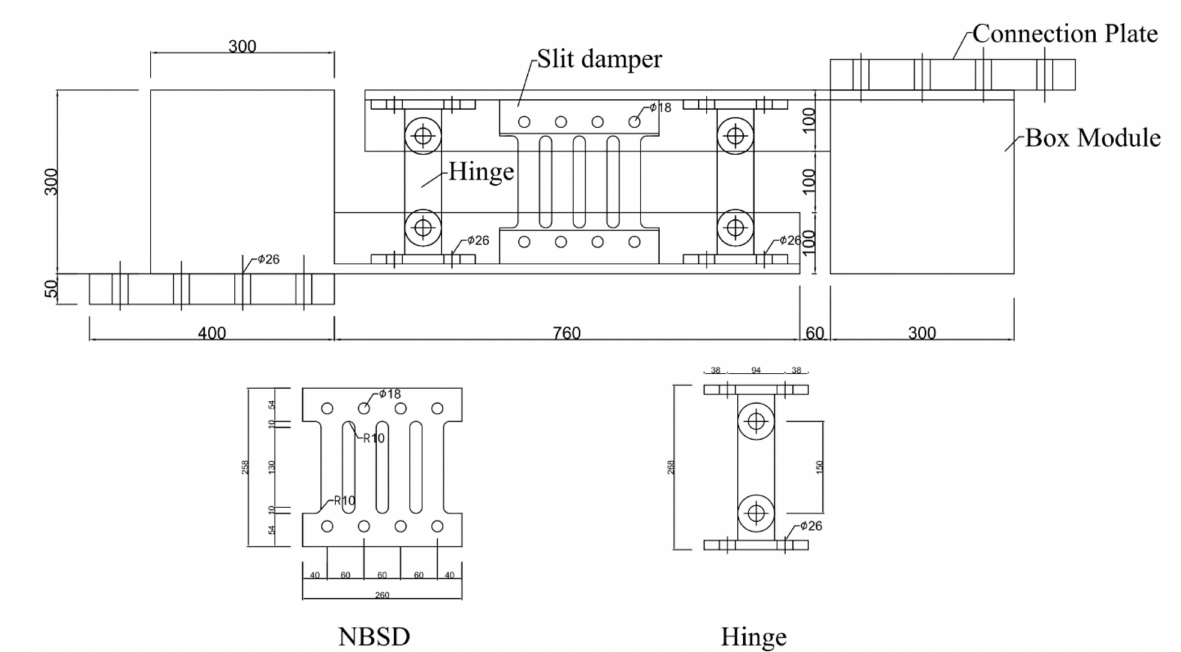
Figure 3. Detailed descriptions of the NBSDs used in the material testing.